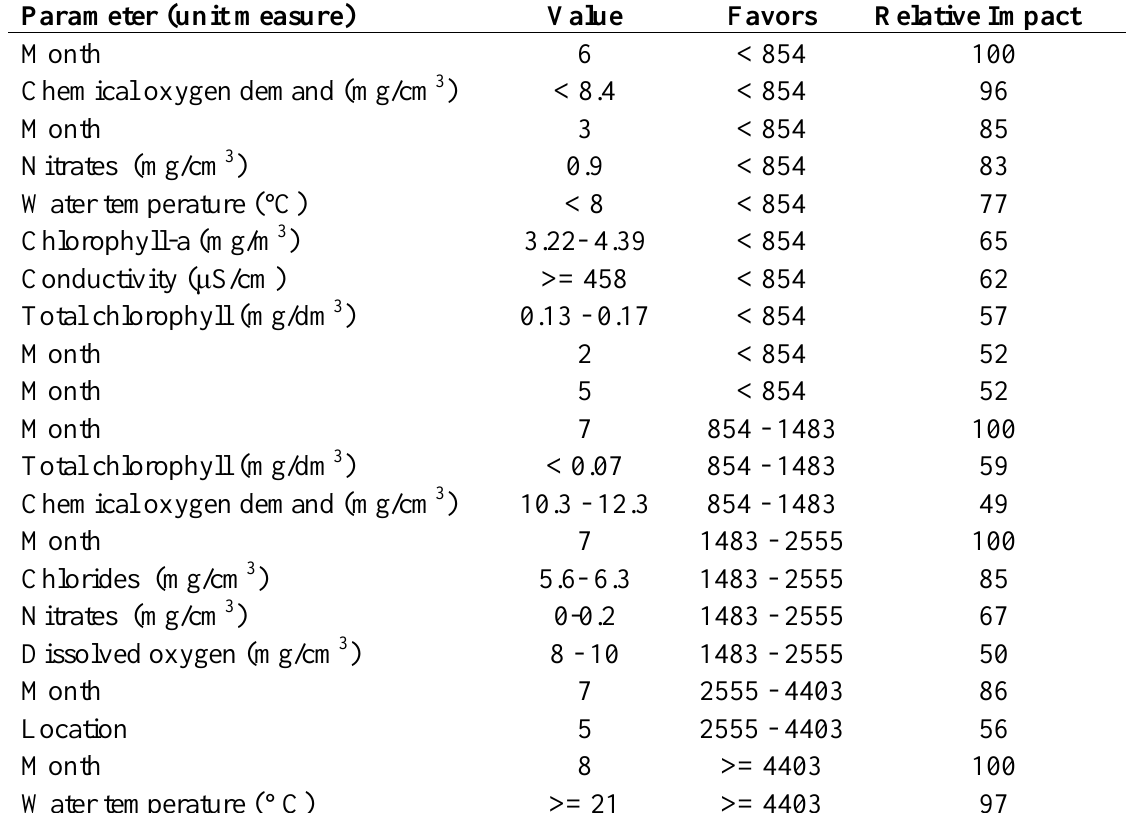
Table 2. Key Influencers Report and their impact over the values of total zooplankton (ind/dm 3 ) without zooplankton groups and species for the Grošnica